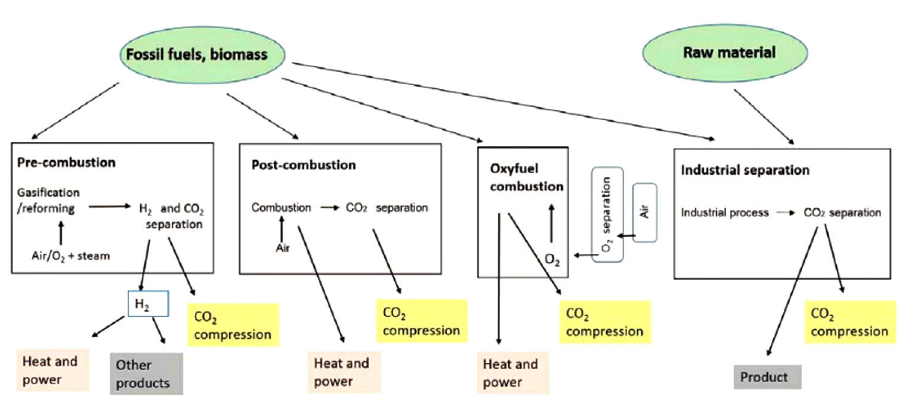
Fig. 12. – Schematic representation of carbon capture systems